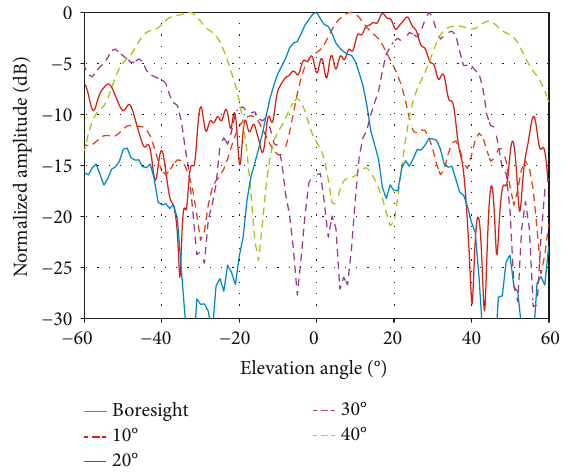
Figure 17: The measured normalized radiation patterns for beam- steering angles in the elevation plane.